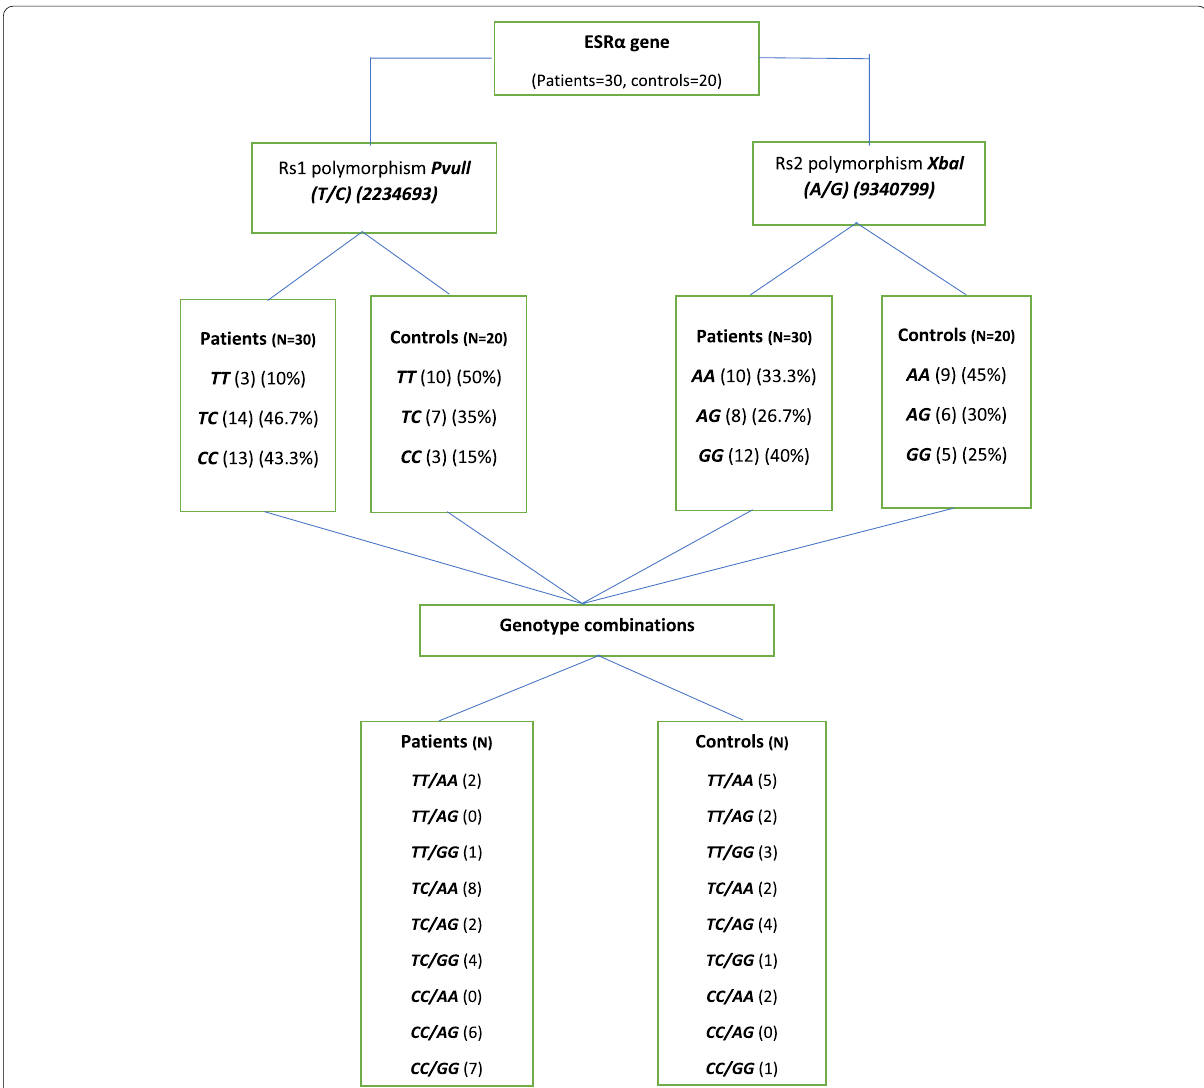
Fig. 1 Flow chart of the ESRα polymorphism